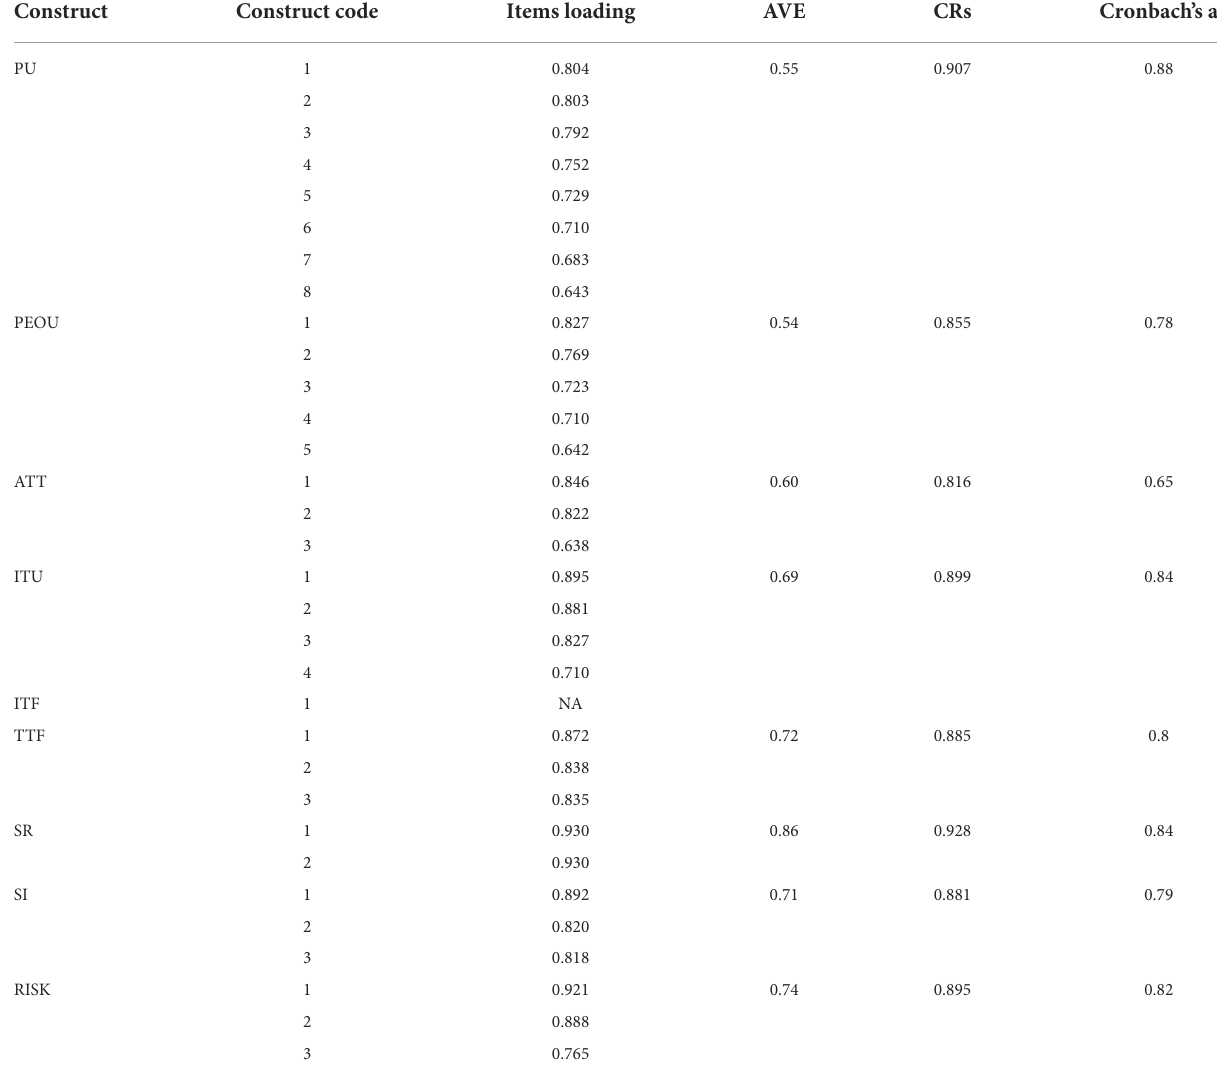
TABLE 2 Construct reliability and convergent